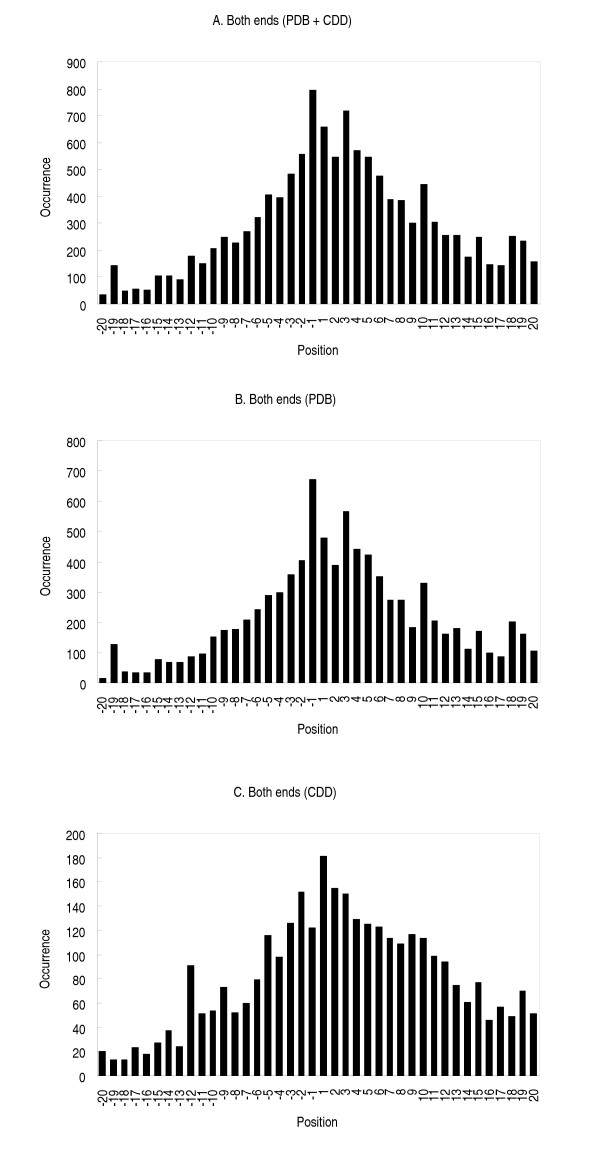
Correlation between the positions of domain linkers and putative structural domains. The horizontal scale represents the number of residues in the error window between the linker termini and the corresponding putative structural domain termini. This is calculated as the number of residues separating the last residue (or the first residue) of a domain linker in Classes 1 and 2 from the first residue (or respectively the last residue) of the corresponding putative structural domain. (A) Distribution calculated for putative structural domains detected by similarity to PDB and CDD, (B) to PDB, and (C) to CDD.